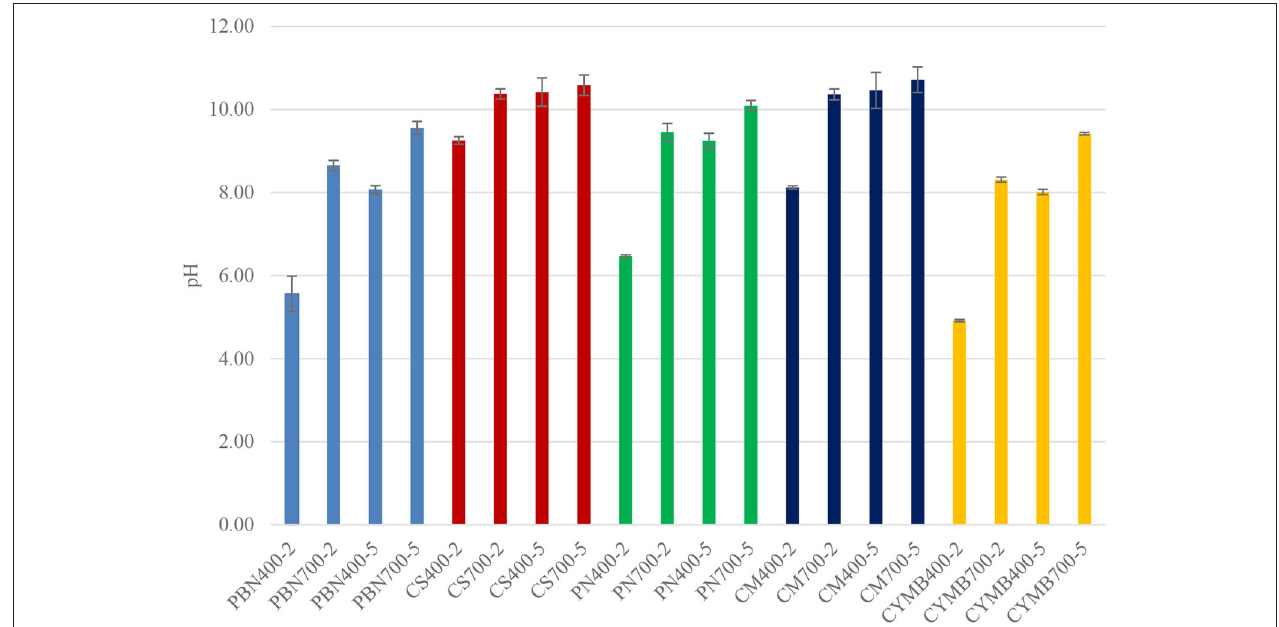
FIGURE 1 | pH of biochar produced at 400 and 700 ◦ C for 2 and 5h. Each kind of biochar is marked with one color (pine bark = blue, corn stover = red, pine needles = green, cow manure = dark blue, cypress mulch =